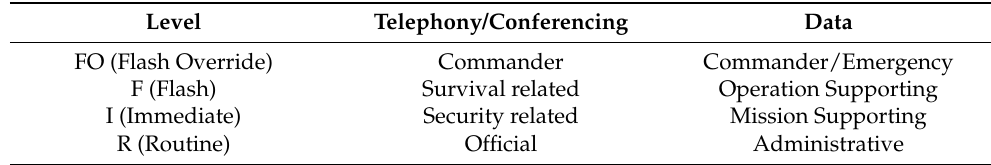
Table 3. Importance